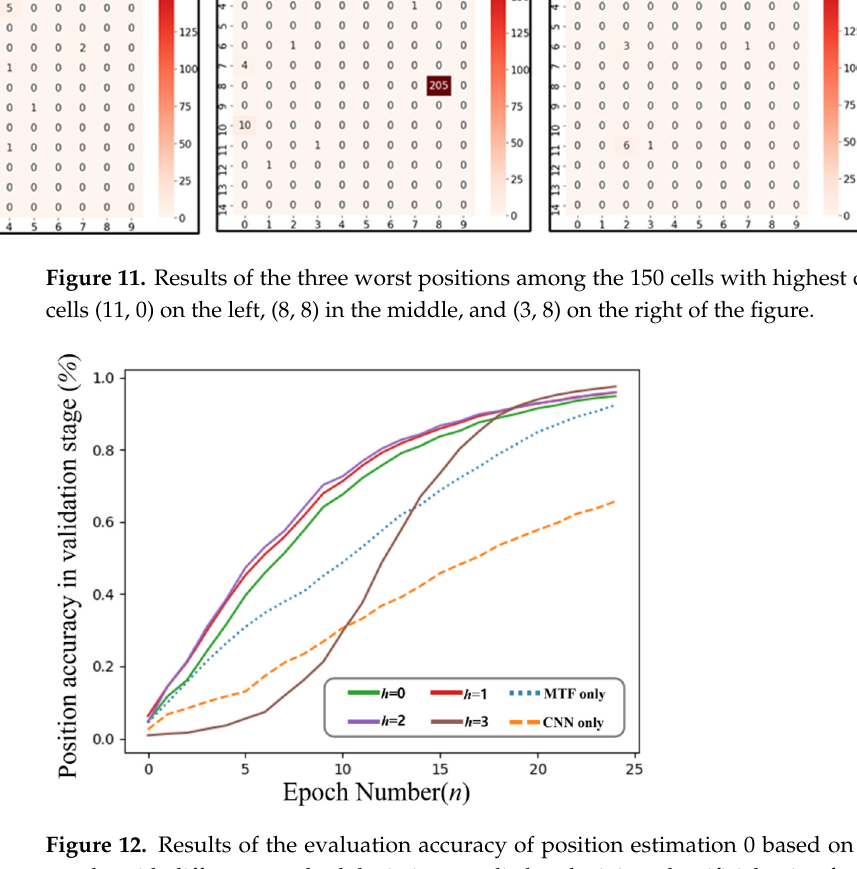
Figure 12. Results of the evaluation accuracy of position estimation 0 based on the increment of epochs with different standard deviations applied to the injected artificial noise, from the perspective of the x -axis (left) and y -axis (right) on the testbed.